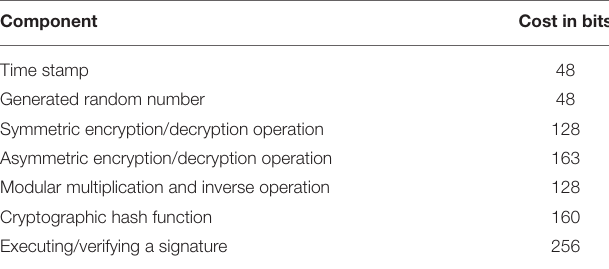
TABLE 4 | Communication cost of various components in